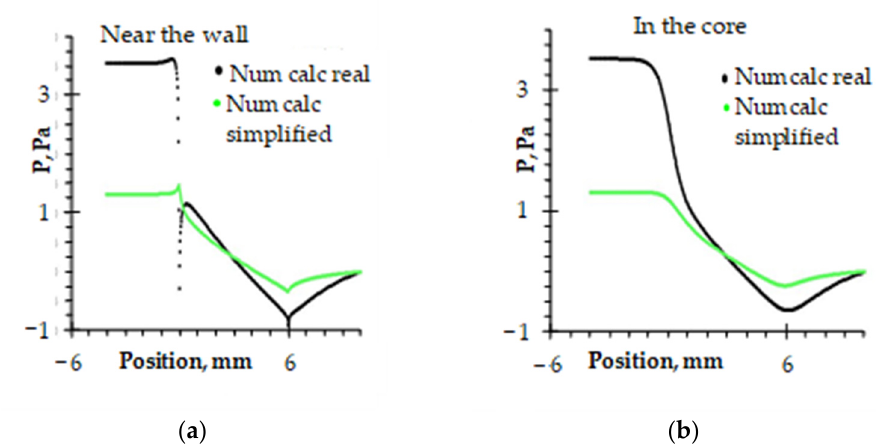
Figure 3. Comparison of numerical and experimental results for tested structure.